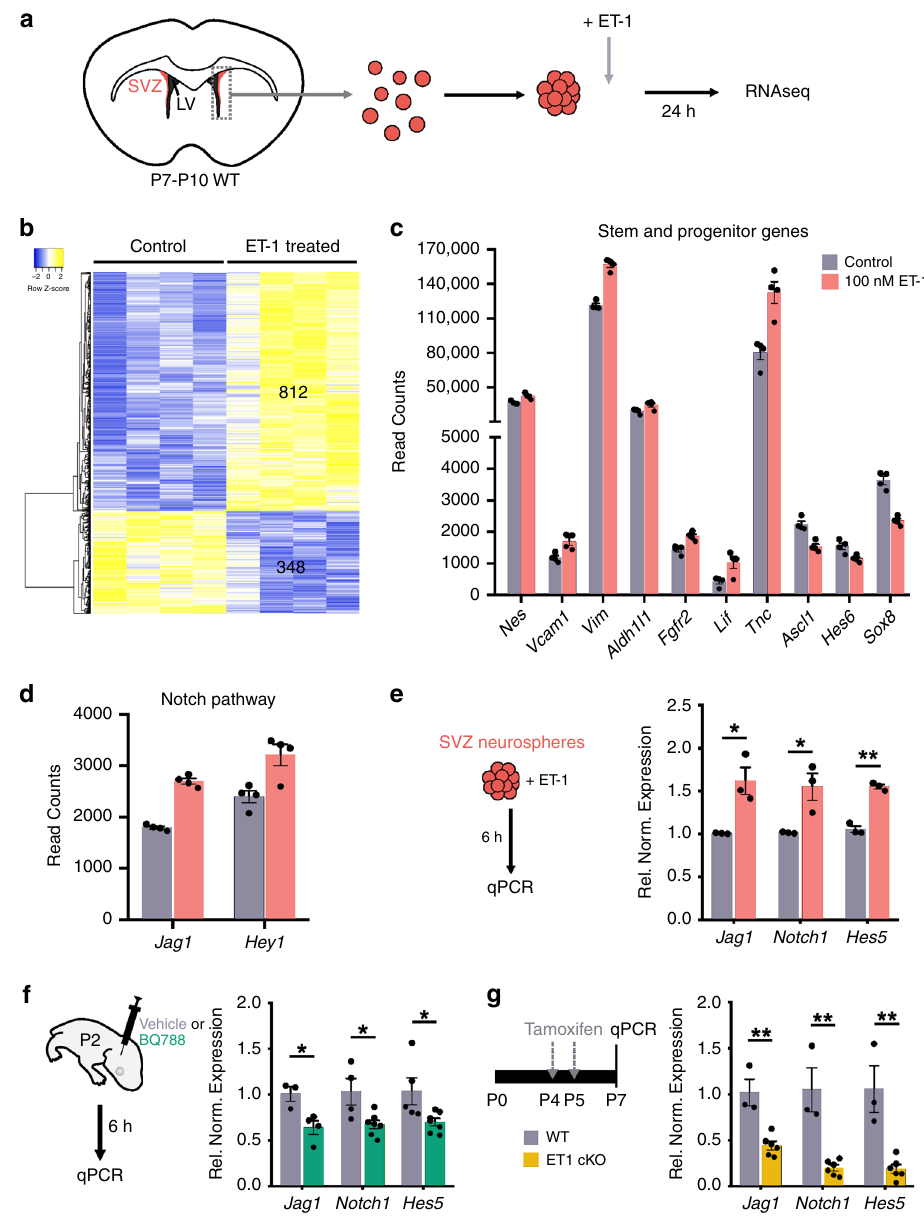
Fig. 4 ET-1 regulates radial glial proliferation via Notch activation. a Experimental procedure. b Heatmap depicting signi fi cant differentially expressed genes (DEGs) between control and ET-1-treated neurospheres. c Quanti fi cation of read counts of stem and progenitor genes that were signi fi cantly altered by ET-1 treatment ( n = 4 independent batches). d Quanti fi cation of read counts of Notch pathway genes that were signi fi cantly altered by ET-1